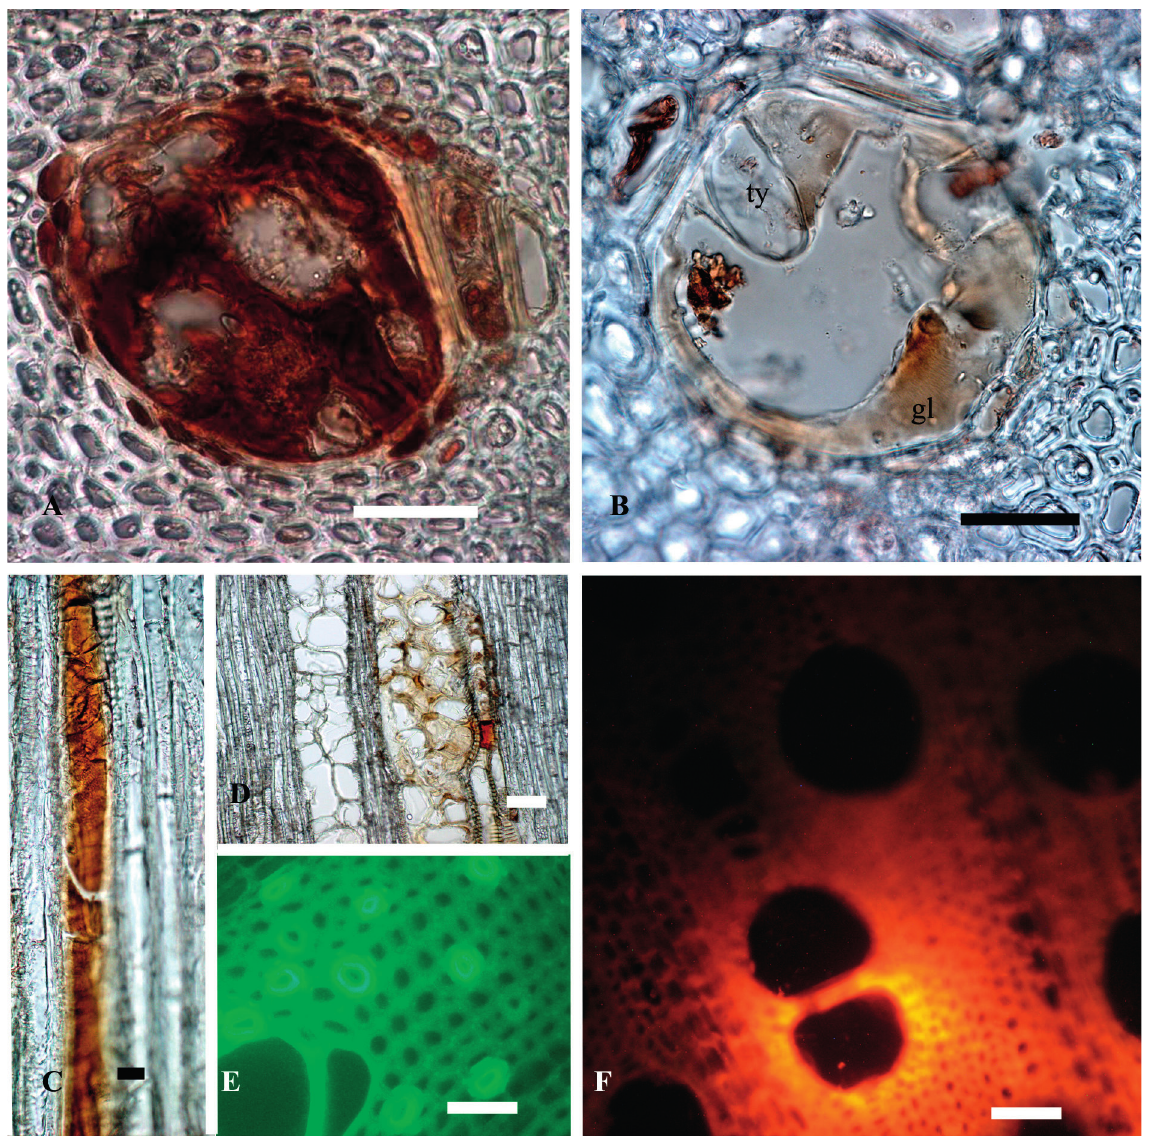
Figure 2. Grapevine wood tissue response to infection of one-year-old canes by Phaeomoniella chlamydospora and Eutypa lata . A. Transverse section (t.s) of xylem vessels occluded by gum (or gel) in P. chlamydospora inoculated cane. B. Tyloses (ty) and gum (gl) co-occurring in the same xylem vessel of a cane inoculated with P. chlamydospora (t.s). C and D. Full length vessel elements blocked by gum (C) and tyloses (D) in P. chlamydospora infected vessel. F. Increased fluorescence and wall thickening of fibre cells from E. lata infected canes. Scale bars, 50 µ